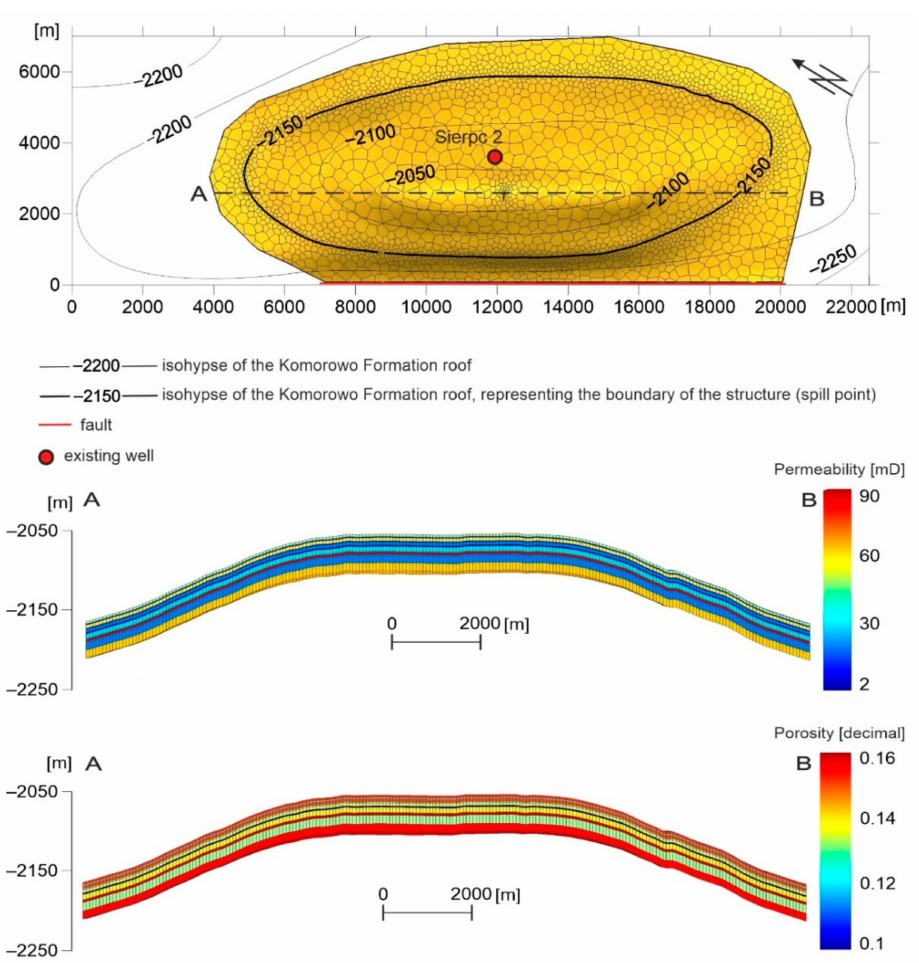
Figure 3. The area selected for modeling against the background of the Sierpc structural map and the AB cross-sections of the reservoir, illustrating permeability and porosity changes (based on [53] with the author’s